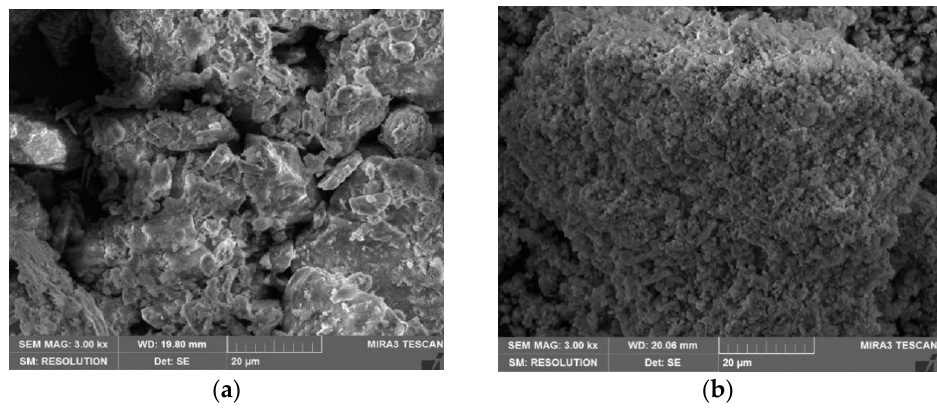
Figure 4. The SEM images (3.00 k×) of ( a ) loess, ( b ) red mud.